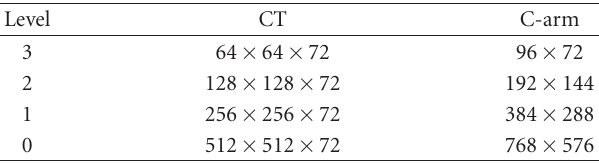
Table 1: Volume (CT) and image (C-arm) pyramid size in voxel/ pixel units.